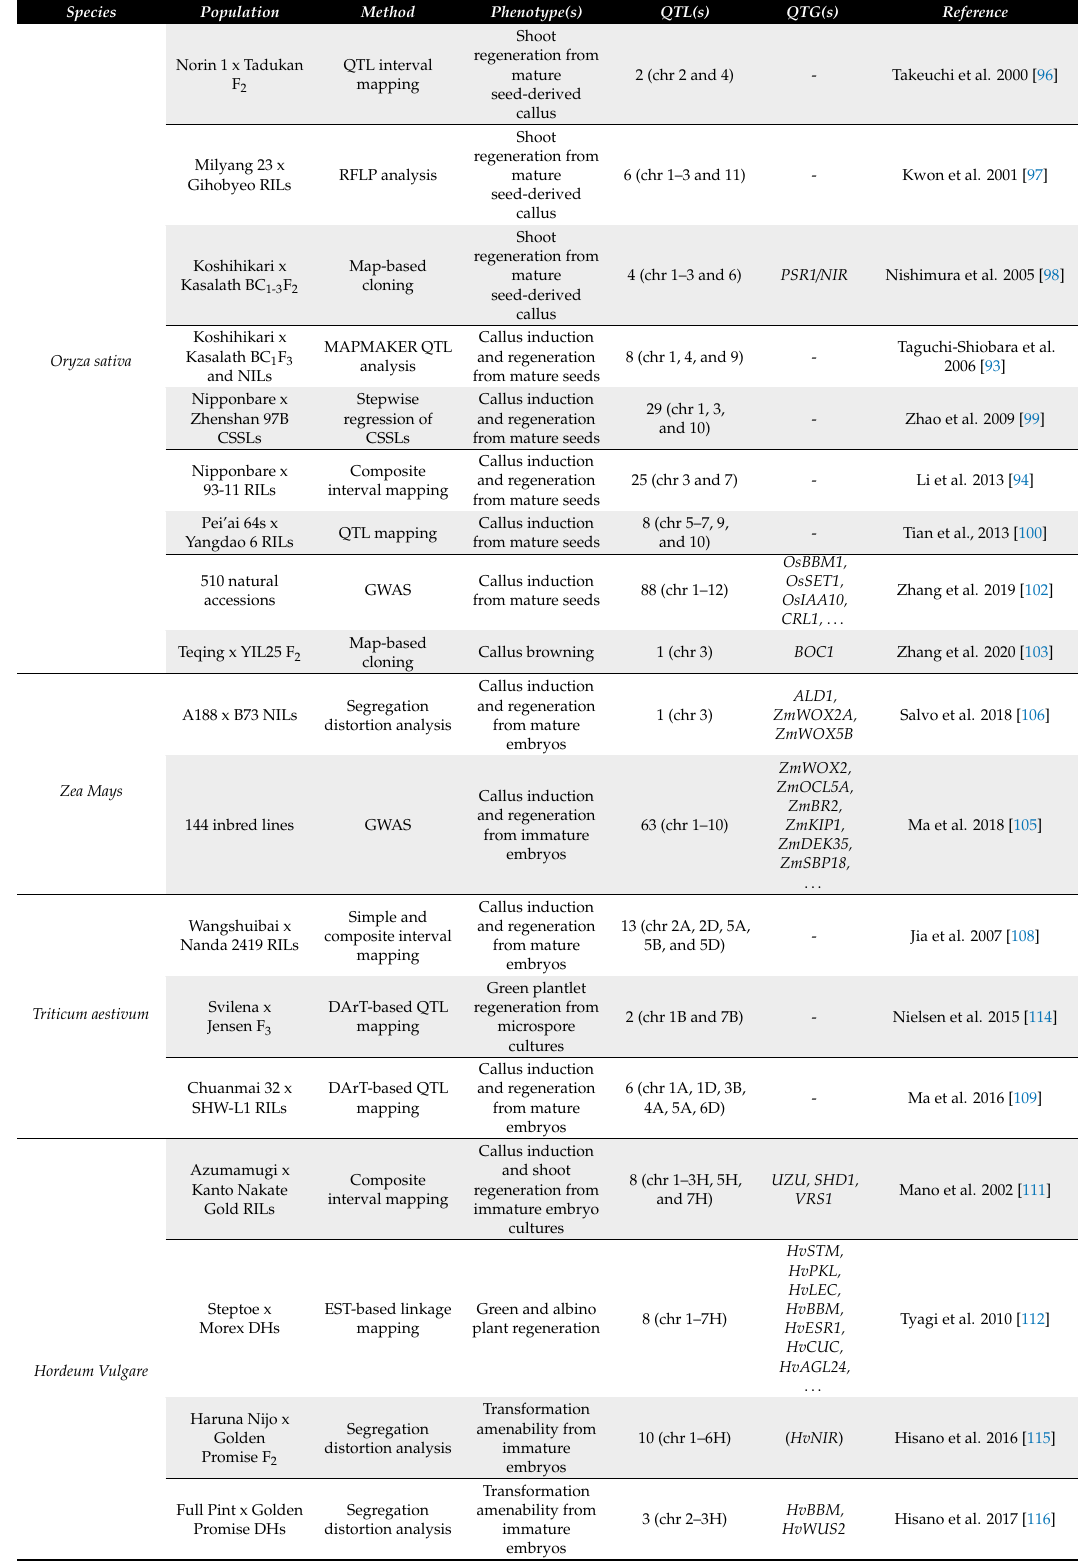
Table 2. Nonexhaustive overview of QTL mapping studies on regeneration in monocot crops since 2000. The QTL and QTG columns respectively specify the number (and chromosomal position) of quantitative trait loci and highlight quantitative trait genes (plausible candidates are